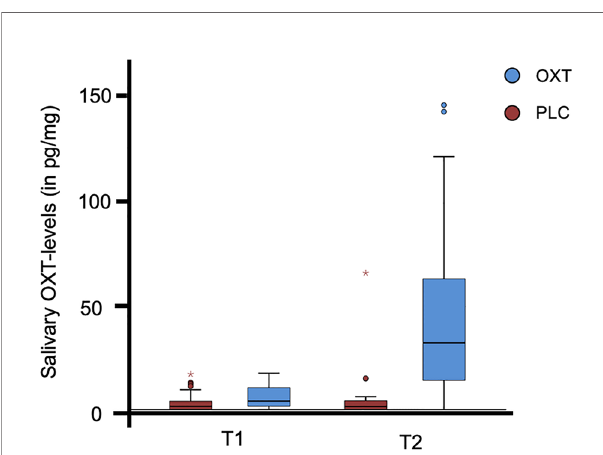
FIGURE 1 | The distribution of salivary oxytocin (OXT) levels for the participants (N = 70). The box plot illustrates the data for both the OXT and the placebo (PLC) group prior to the self-administration of the nasal spray (T1) and after completion of the experimental trial (T2). Three subjects were excluded from the analyses due to incomplete saliva samples. °, values >1.5 times of the interquartile range; * values >3.0 times of the interquartile